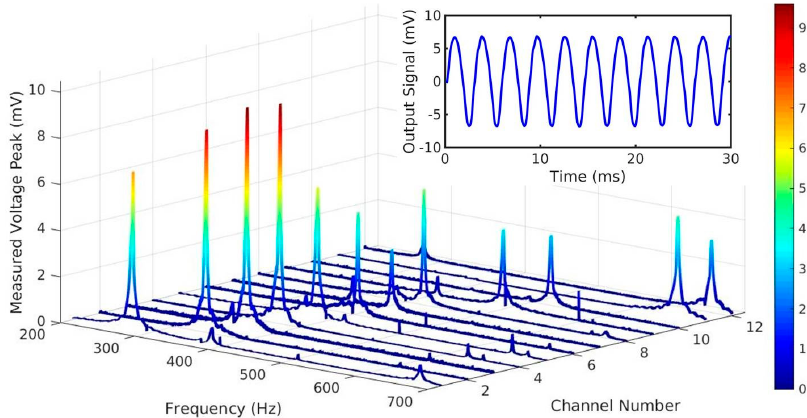
Figure 6. Piezoelectric output voltage during continuous sinusoidal excitation at a feedback controlled acceleration of 1 g. Depending on the geometry, the base frequency of the cantilevers falls in the range of 281–673 Hz. Inset shows the sinusoidal output waveform of channel 1 at resonance.